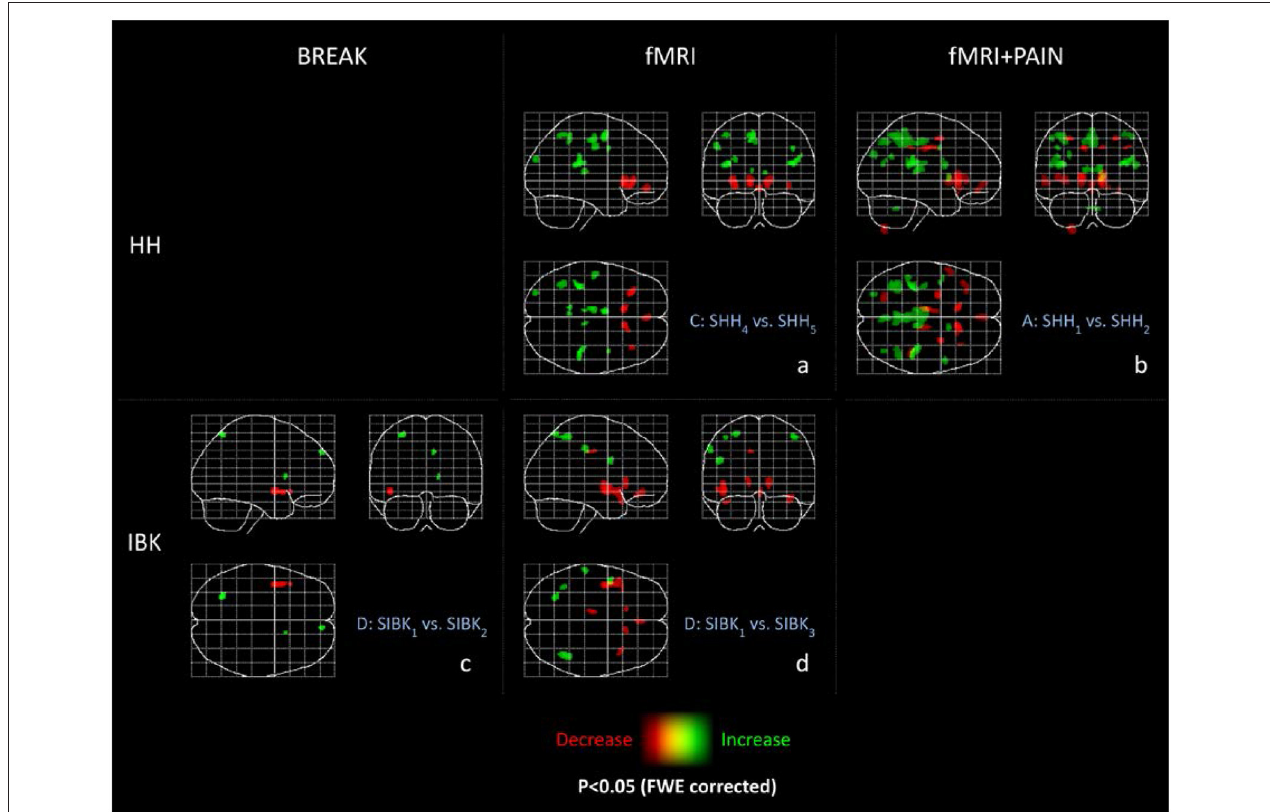
FIGURE 2 | Maximum intensity projections (MIP) of all experiments. These maximum intensity projections summarize the T-statistics of all experiments. Indicated are increases (green) and decreases (red) in GM volume. All results are thresholded at p < 0.05 FWE-corrected and only clusters are displayed with a minimum cluster size of 36 voxels (according to a cluster size threshold of p < 0.05) as MIP. The abbreviations of the experiments are according to the naming scheme in Figure 1 .